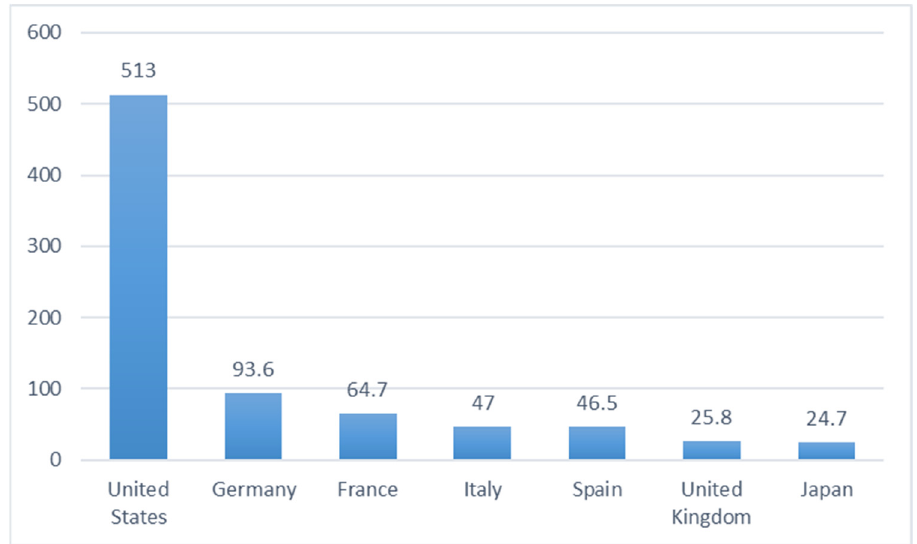
Figure 1. Top 7 countries’ dose donation to COVAX as of 17 January 2022 (unit: million). Source: Gavi, the Vaccine Alliance, “Break COVID Now: The Gavi COVAX AMC Investment Opportunity”.